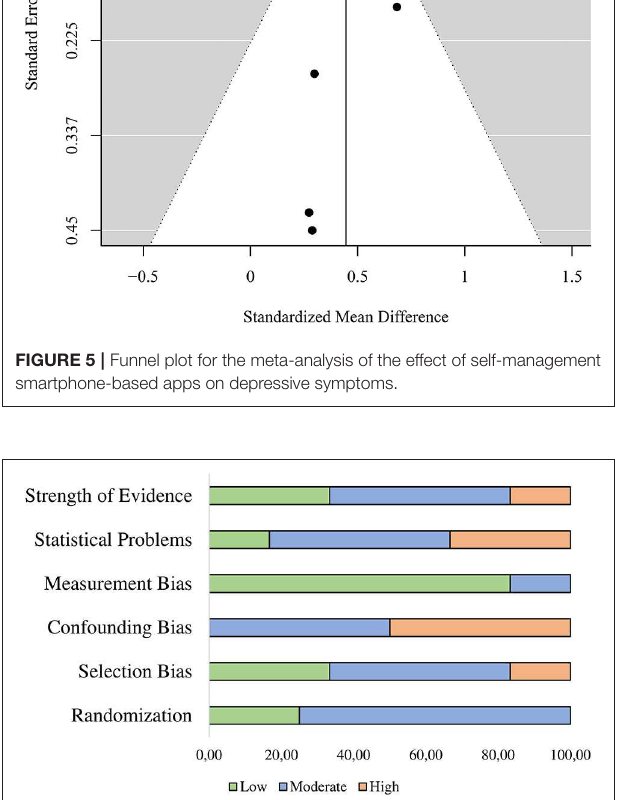
FIGURE 6 | Graphical Representation of the Risk of Bias